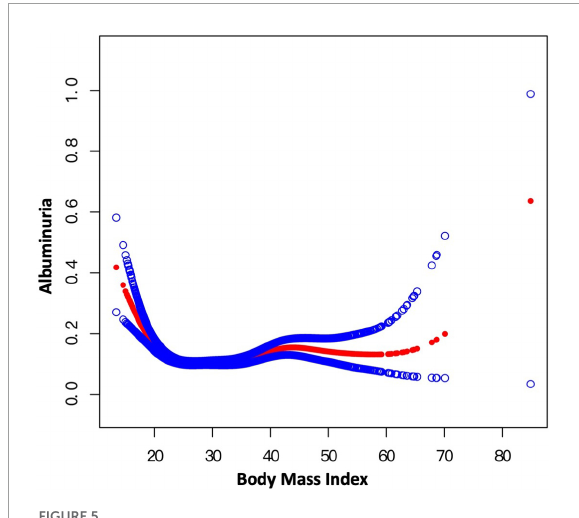
FIGURE5 Smooth curve fitting for BMI and albuminuria. Non-linear relationship between BMI and albuminuria was detected by the generalized additive model.